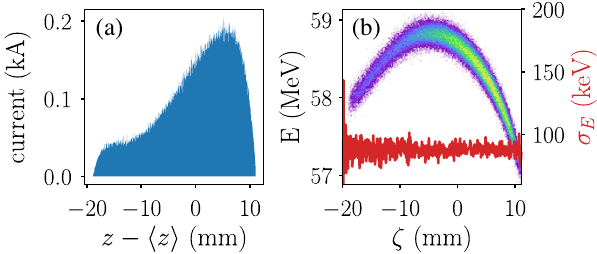
FIG. 13. Current profile (a) and associated LPS (b) distributions simulated with ASTRA at the end of the photoinjector (see Fig. 6) with added uncorrelated fraction energy spread following a Gaussian distribution with rms spread σ plot (b) the red trace represents the slice rms energy spread σ